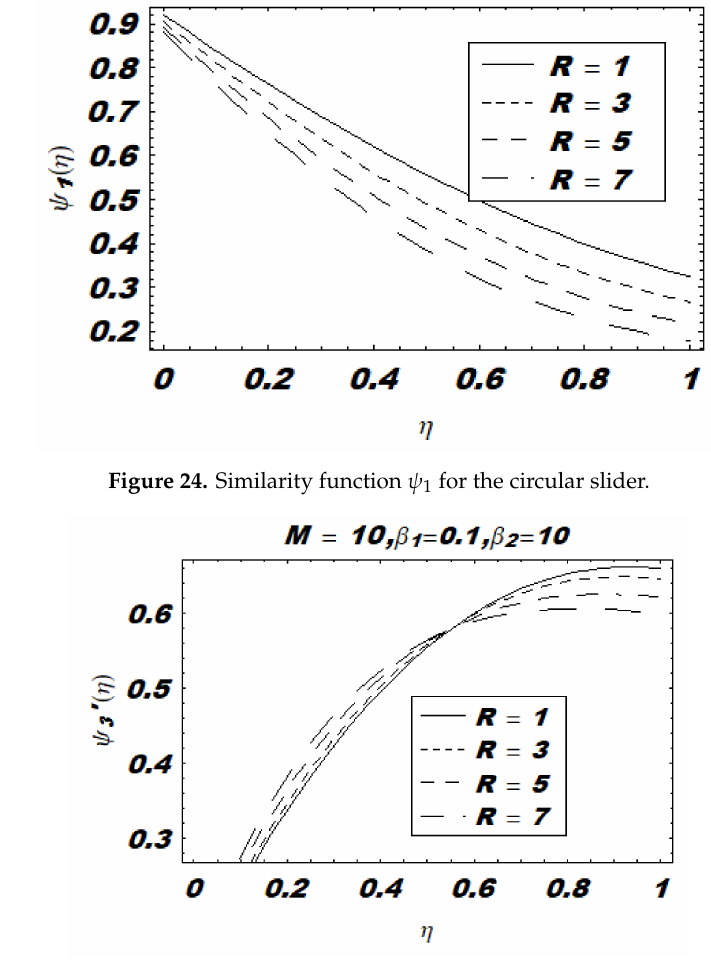
Figure 25. Similarity function ψ /